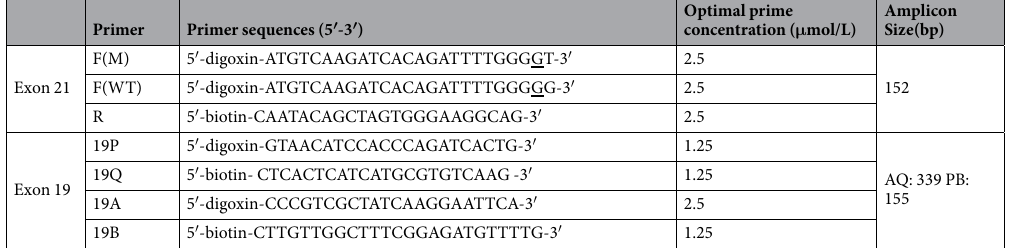
Table 4. Primer sequences and PCR parameter.